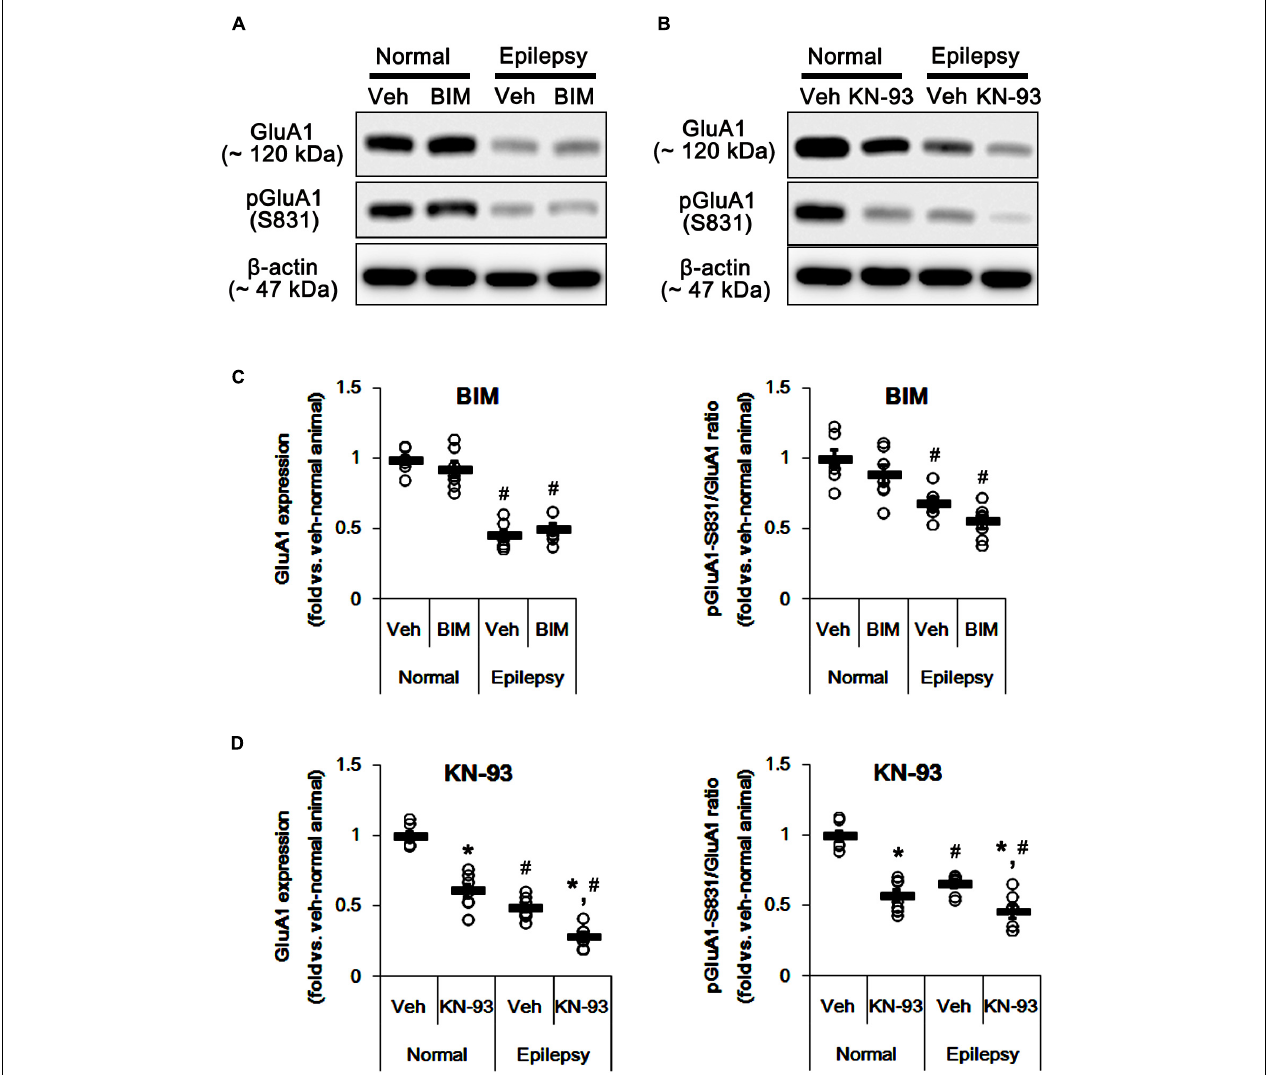
FIGURE 5 | Effects of BIM and KN-93 on GluA expressions and their phosphorylations. (A,B) Representative images for western blot of GluA1, phospho (p)-GluA1-S831, and pGluA1-S845 in the hippocampal tissues obtained from 3-days infused groups (B) . (C,D) Quantifications of GluA1, pGluA1-S831, and pGluA1-S845 levels in BIM- (C) and KN-93 infused groups (D) . Open circles indicate each individual value. Horizontal bars indicate mean value. Error bars indicate SEM ( ∗ , # p < 0.05 vs. vehicle-treated animals and normal animals, respectively; n = 7, respectively).